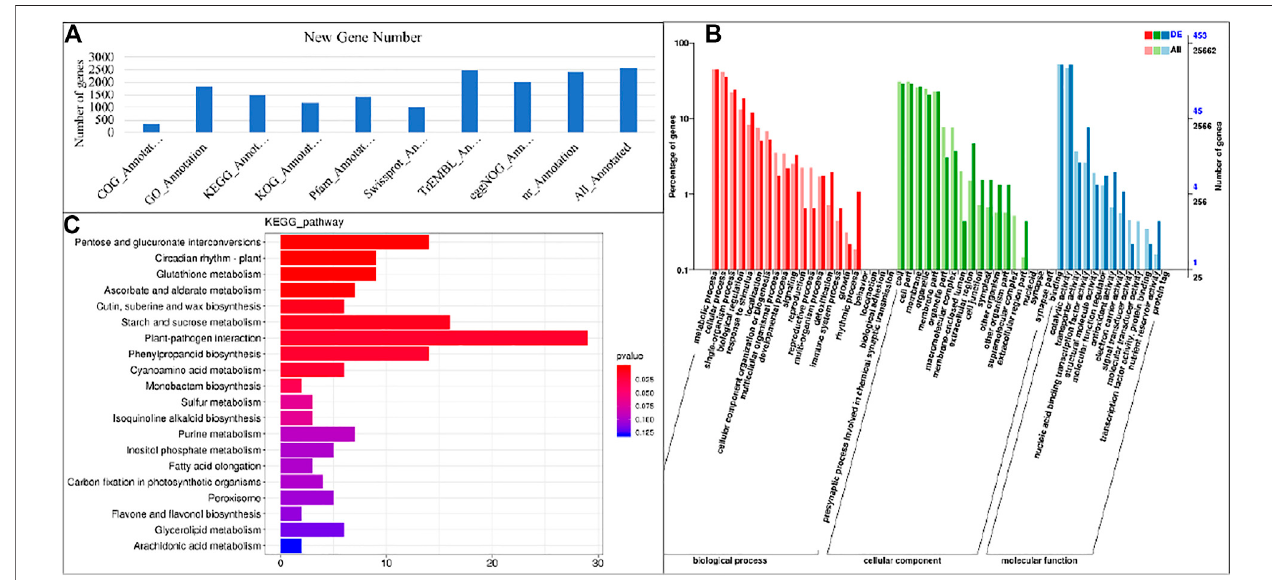
FIGURE 3 | (A) Annotation summary of newly identi fi ed genes and Representation of gene ’ s enrichment in KEGG and GO pathways. (A) Gene ontology classi fi cation of assembled genes and (B) Histogram of enrichment of differentially expressed genes in KEGG pathways in S1 vs. S2.